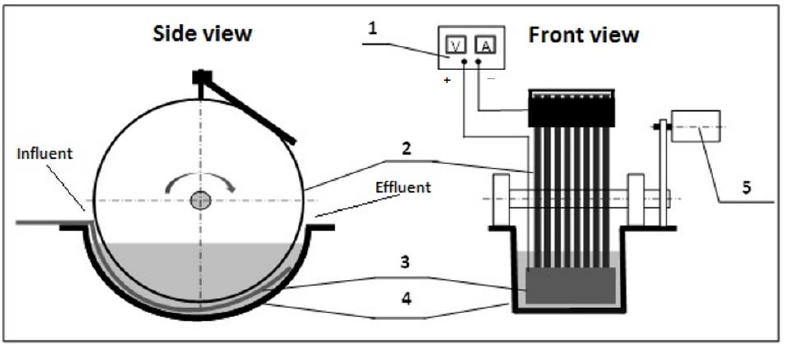
Figure 1. Scheme of unit experimental model: 1 — laboratory DC power supply, 2 — discs (cathode), 3 — anode, 4 — tank, and 5 — electric engine.